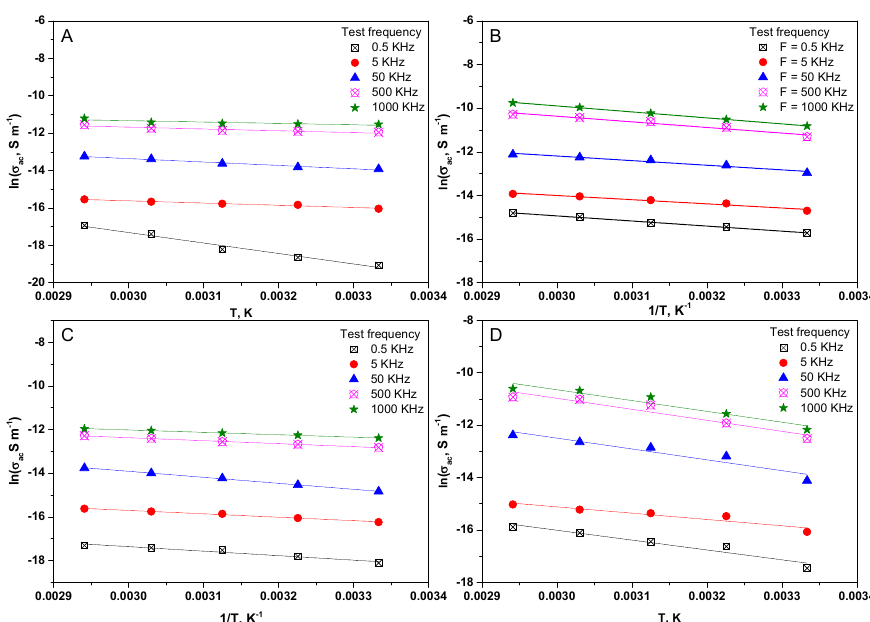
Figure 6. Dependence of ln( σ ac) on the temperature at different frequencies for ( A ) poly(EDMA), ( B ) Pd(OAc) 2 /poly(EDMA)-5.1%, ( C ) poly(EDMA-co-MMA), and ( D ) Pd(OAc) 2 /poly(EDMA-co- MMA)-1.6%.